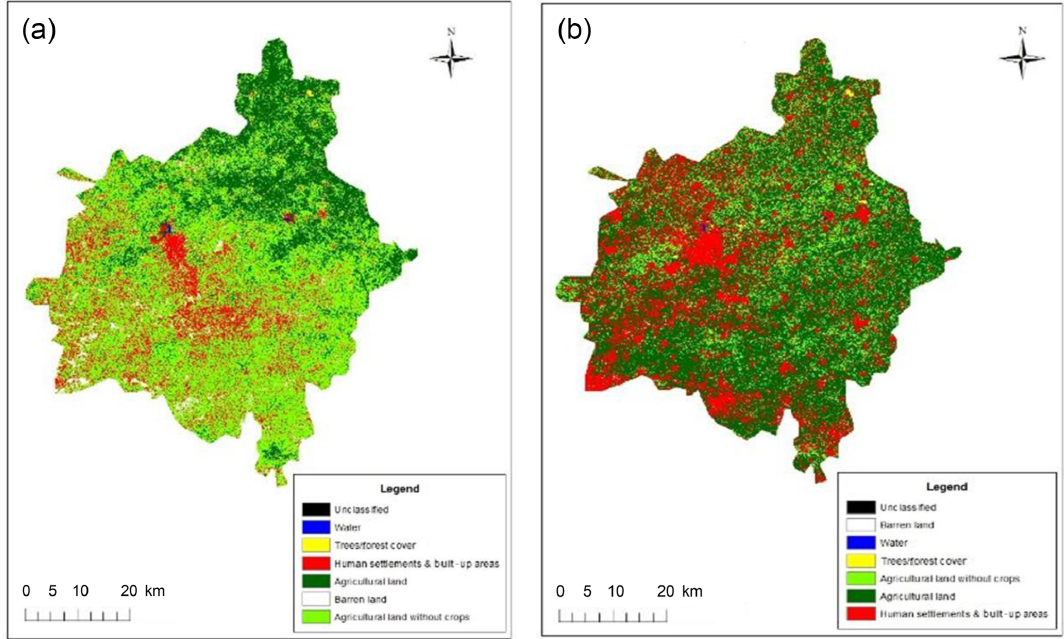
Figure 4. LULC map (supervised classification) of Bathinda for (a) 2000 and (b) 2014.